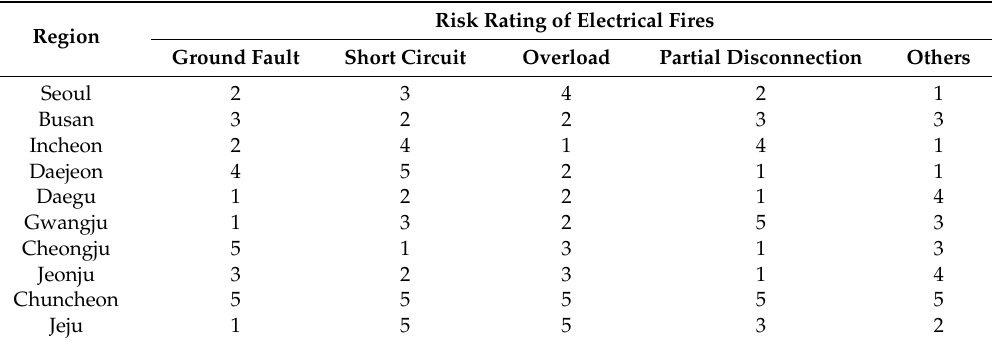
Table 6. The risk rating for electrical fires by